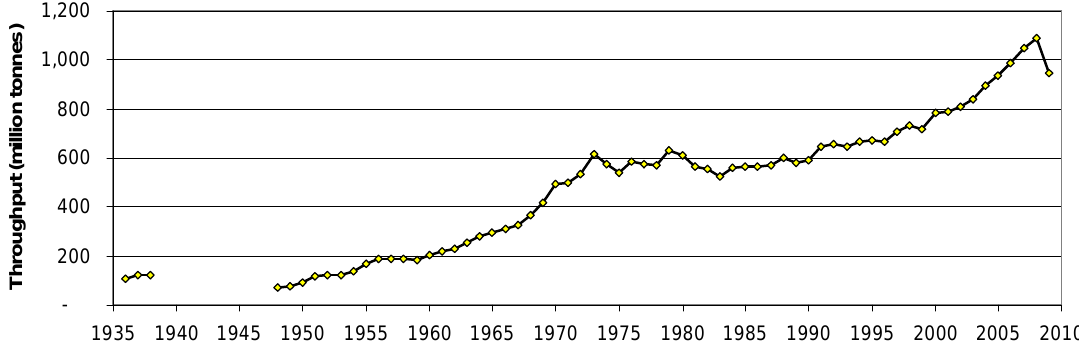
Figure 2. Historic development of throughput volumes in the Le Havre – Hamburg range The forecast presented in this paper refers to the eight ports summarized in Figure 2. For 2008 and 2009 these ports accounted for about 90% of the total throughput in the Le Havre Hamburg range (based on statistics of Rotterdam Port